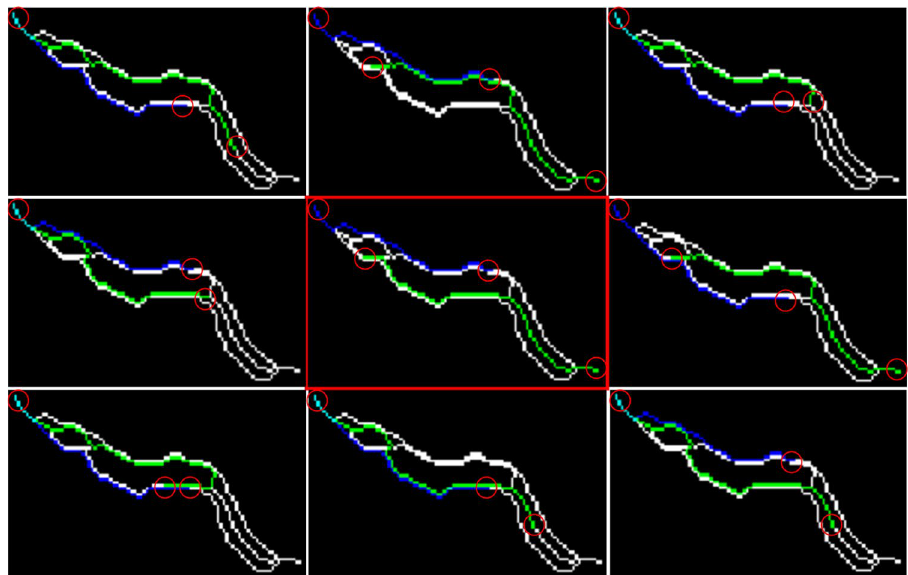
Figure 5. Possible skeleton combinations. Skeleton combinations of two connected worms (blue and green) that will be evaluated by an optimiser to obtain the best possible solution marked by the red